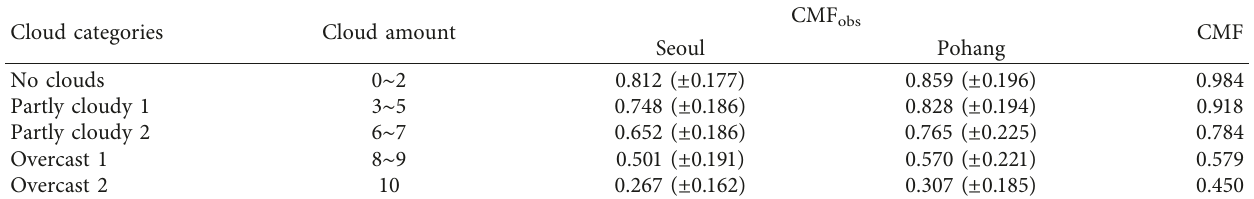
Table 2: Mean and standard deviation of CMF obs with respect to the cloud categories from the numerical weather prediction results. Cloud categories